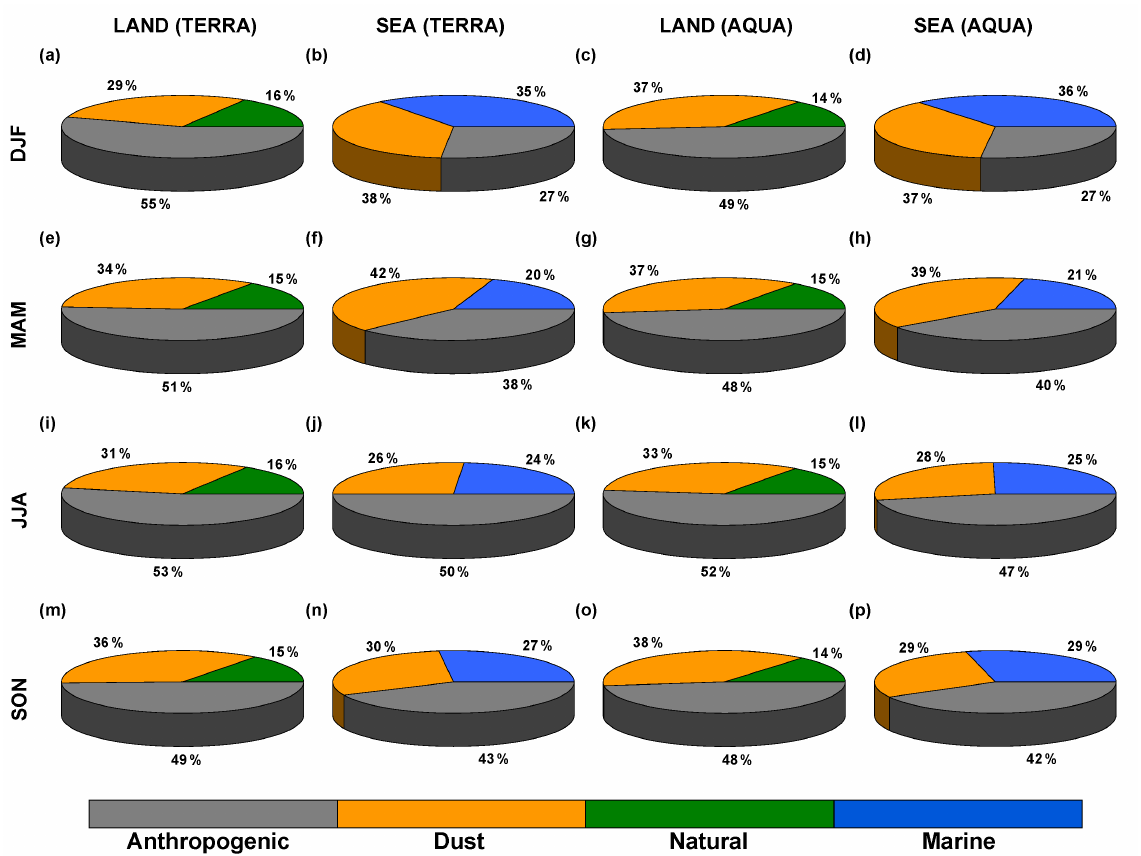
Figure 10. Seasonal relative contribution of anthropogenic aerosols, dust and fine-mode natural aerosols to the total AOD 550 over the land- covered part of the Eastern Mediterranean based on MODIS Terra (a, e, i, m) and MODIS Aqua (c, g, k, o) observations and seasonal relative contribution of anthropogenic aerosols, dust and marine aerosols to the total AOD 550 over the oceanic part of the Eastern Mediterranean based on MODIS Terra (b, f, j, n) and MODIS Aqua (d, h, i, p)